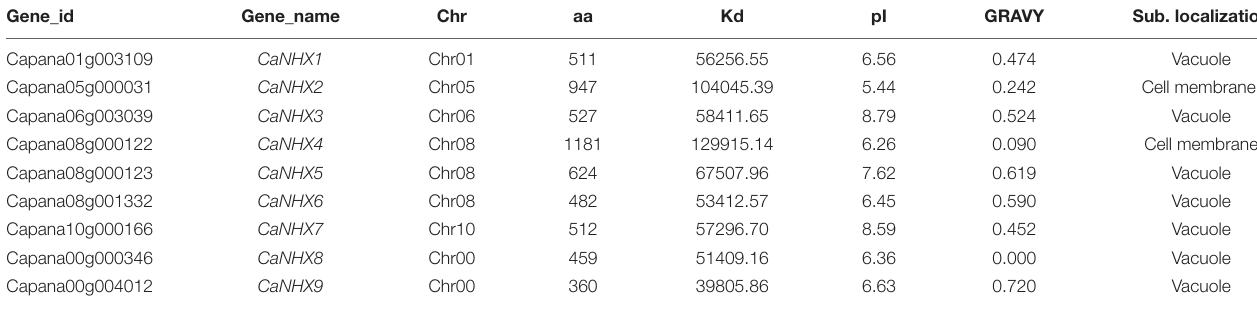
TABLE 1 | Family information and subcellular localization of CaNHX gene in